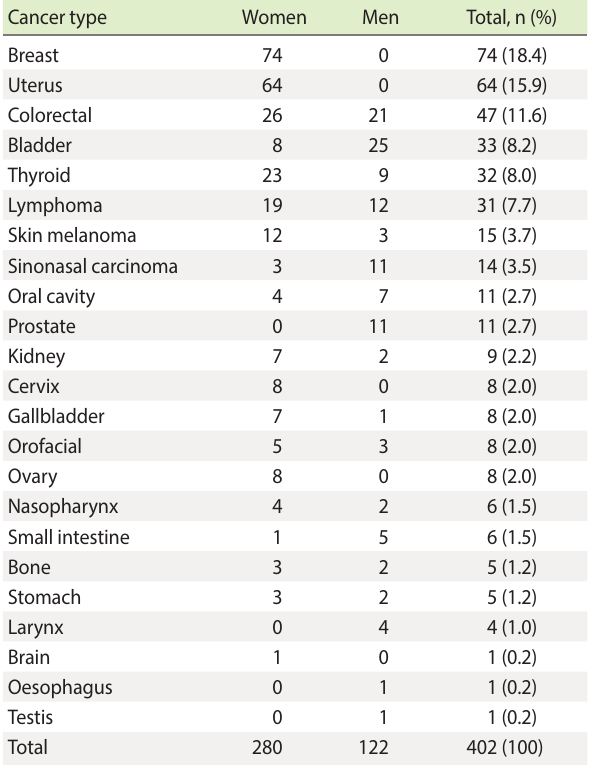
Figure 1. Age distribution and incidence rates of